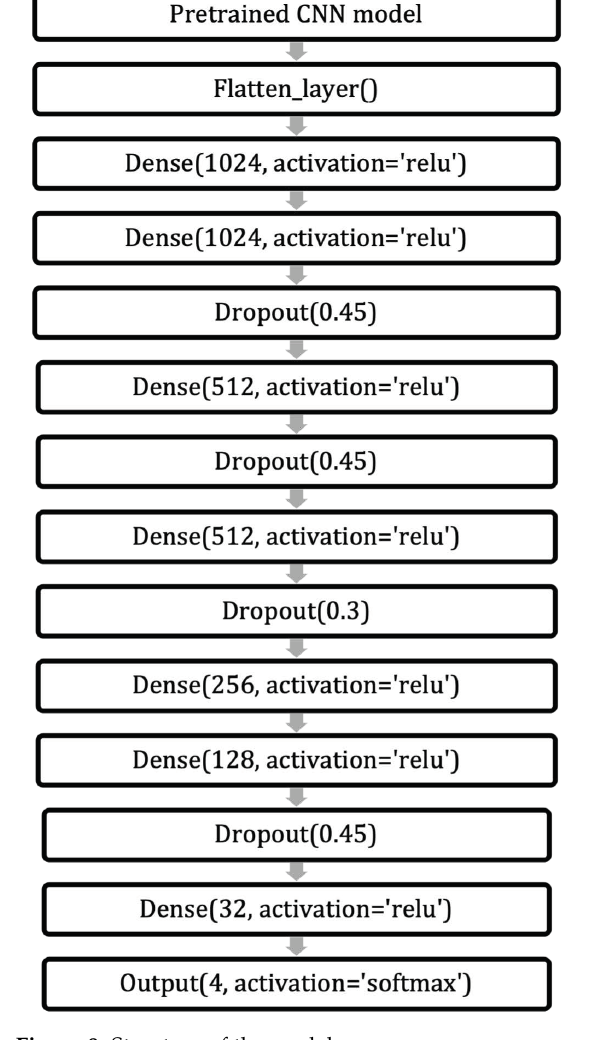
Figure 8. Structure of the